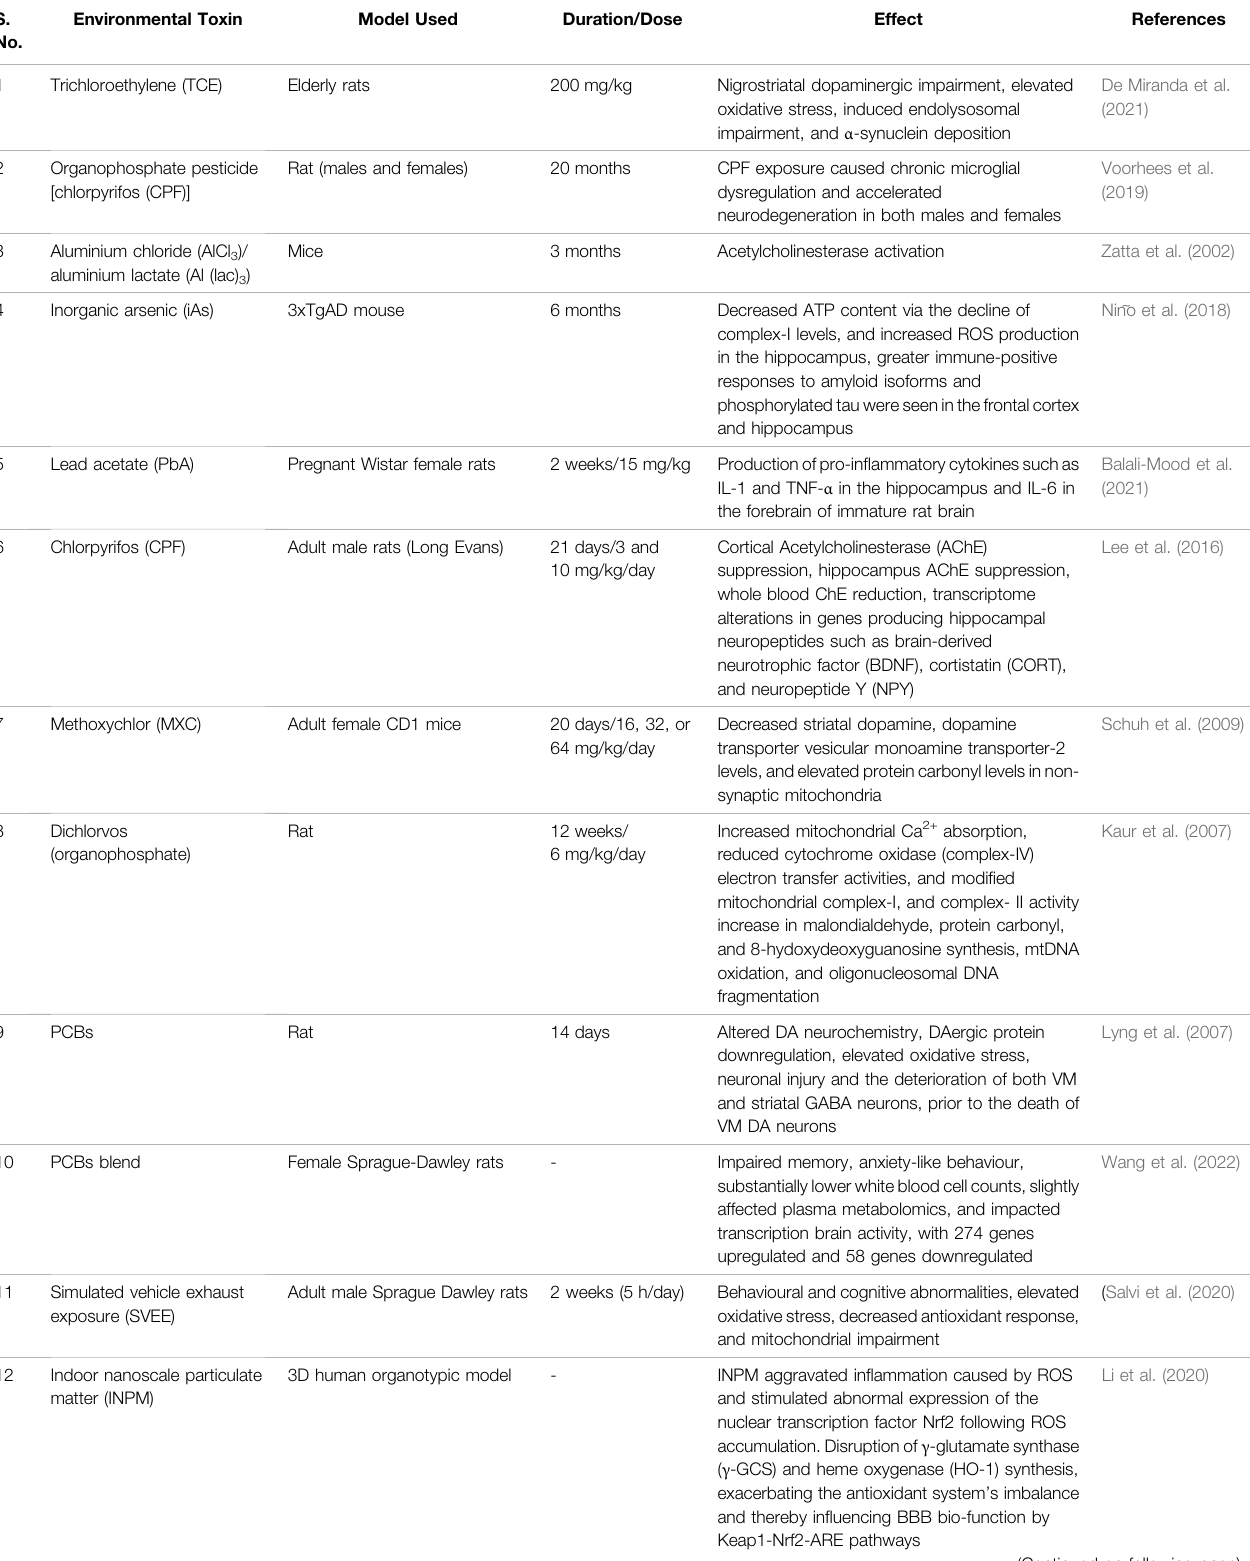
TABLE 1 | Effect of various environmental toxins on neurodegenerative